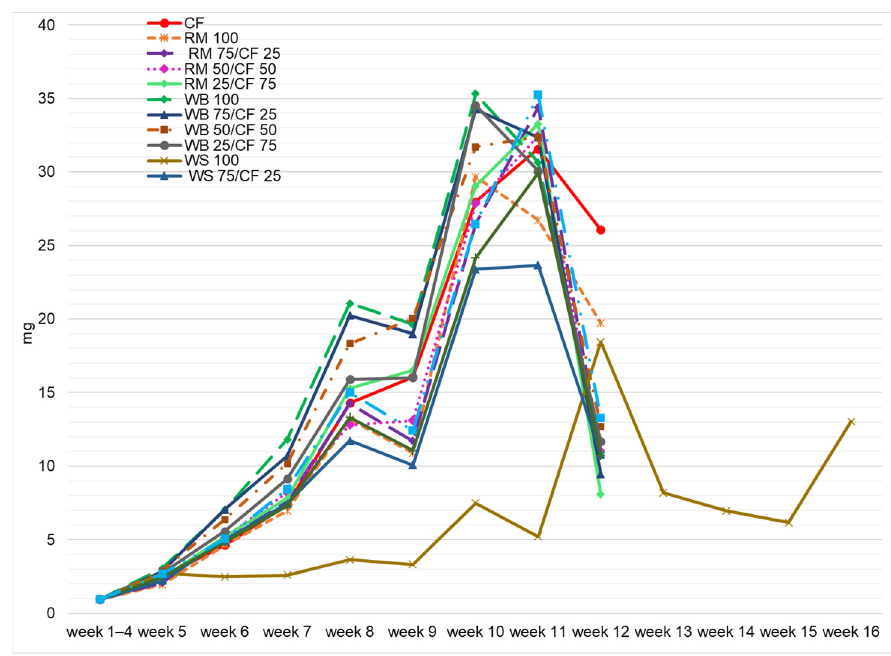
Figure 3. Individual larval weight gain (mg f.m.) depending on the type of diet and week of rearing.